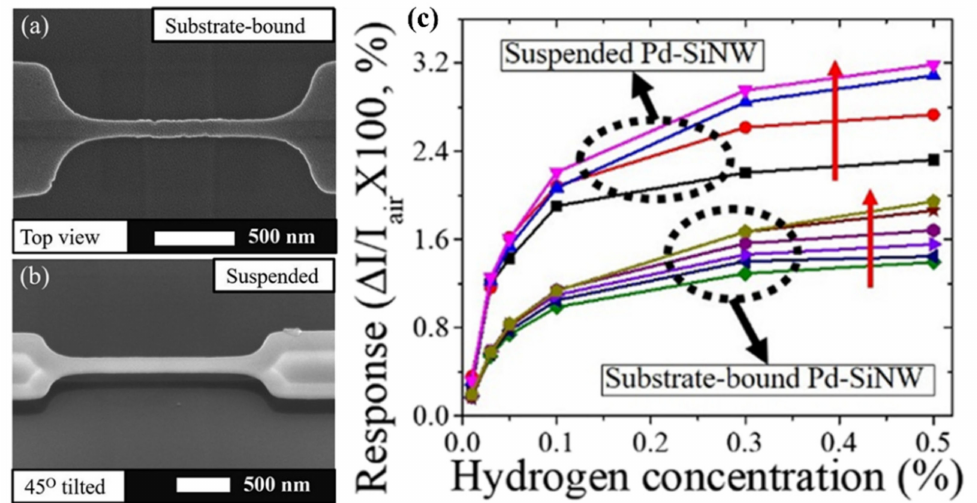
Figure 14. SEM images of a ( a ) substrate bound, and ( b ) suspended SiNW. A comparison between the substrate-bound and suspended Pd-SiNW sensors is shown in ( c ) showing responses with various self-heating powers (red arrows: direction of self-heating power increment (from 41 to 147 µ W for the suspended Pd-SiNW and from 205 to 1172 µ W for the substrate-bound Pd-SiNW)). Reproduced from [141], with permission from American Chemical Society,